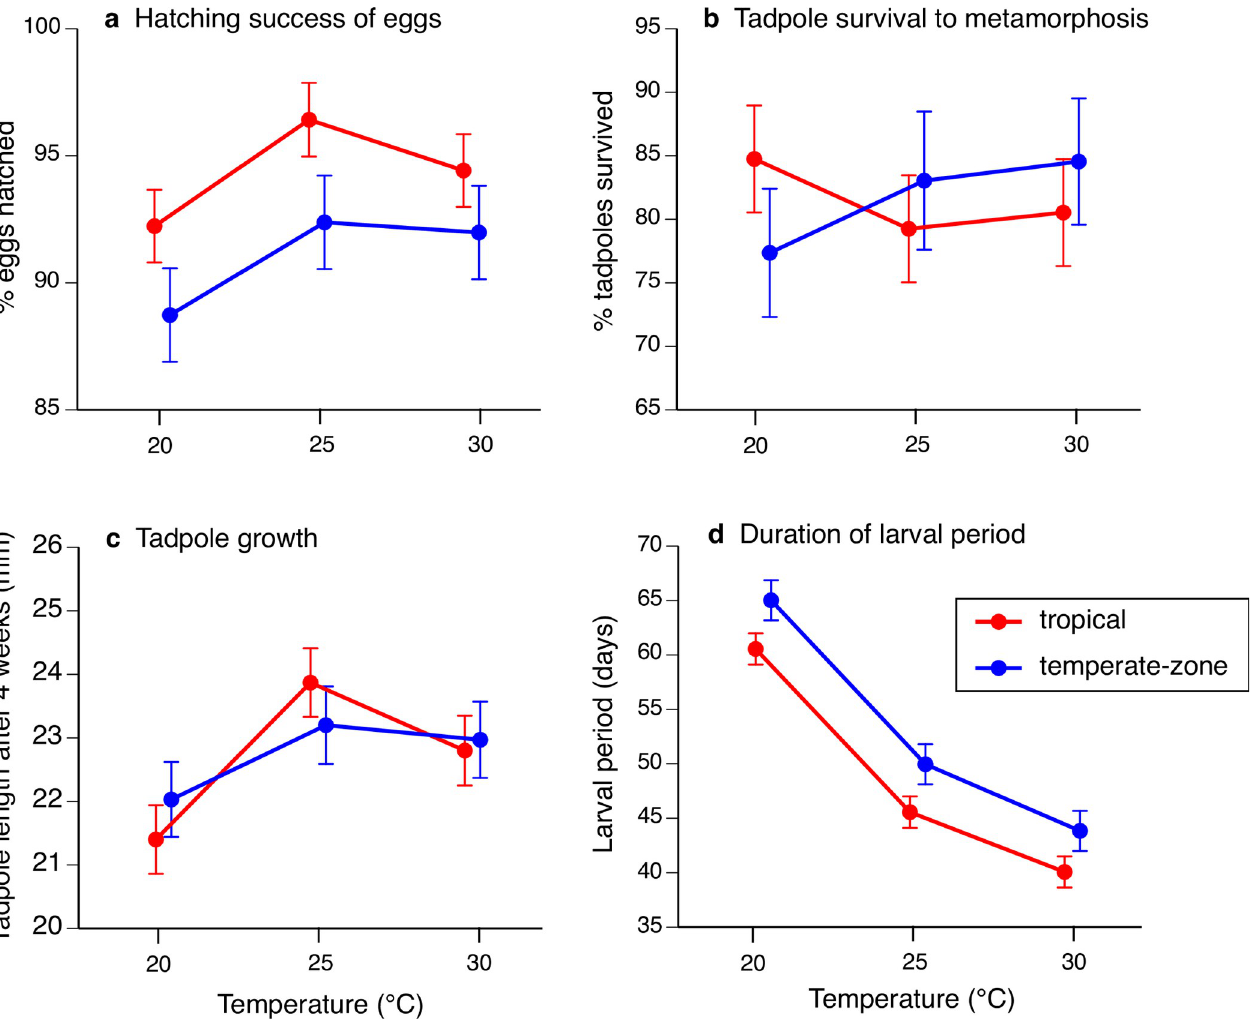
Fig 1. The effects of temperature at which eggs and larvae of cane toads Rhinella marina were raised on hatching success, larval survival, larval growth rate and duration of the larval stage. Graphs show effect of rearing temperature on ( a ) hatching success of eggs, ( b ) survival rates of tadpoles from hatching to metamorphosis, ( c ) body lengths of tadpoles at four weeks of age, and (d) the overall time taken from hatching until metamorphosis. The panels show data from toads whose parents were collected in two locations: tropical (red) and temperate-zone (blue) Australia (Queensland and New South Wales respectively). The figure shows mean values and associated standard errors based on raw data, although some statistical tests in the text are based on arcsin-transformed or ln-transformed values. Tadpoles from tropical populations had higher hatching success (a) and a shorter duration of larval life (d) at all test temperatures, but rates of survival and growth (b and c) did not differ significantly between tropical vs temperate-zone